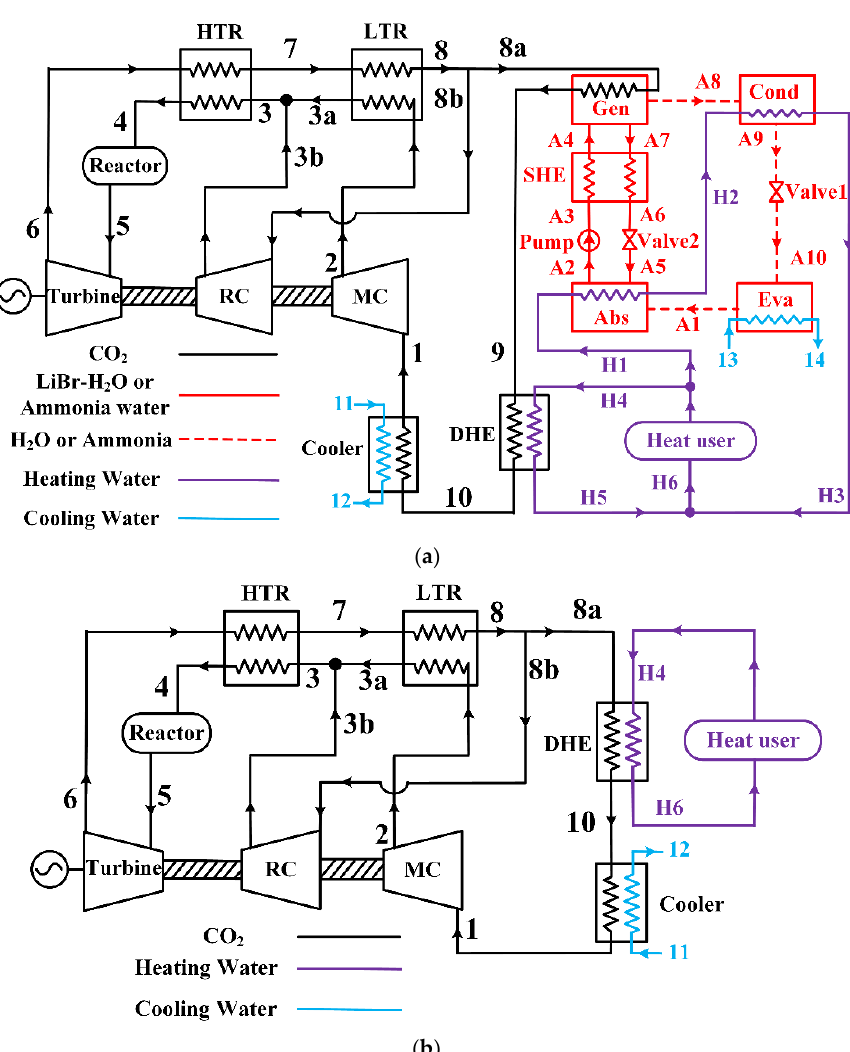
Figure 1. Schematic diagrams of combined heat and power systems: ( a ) sCO 2 / AHP system; ( b ) sCO 2 / DH system.